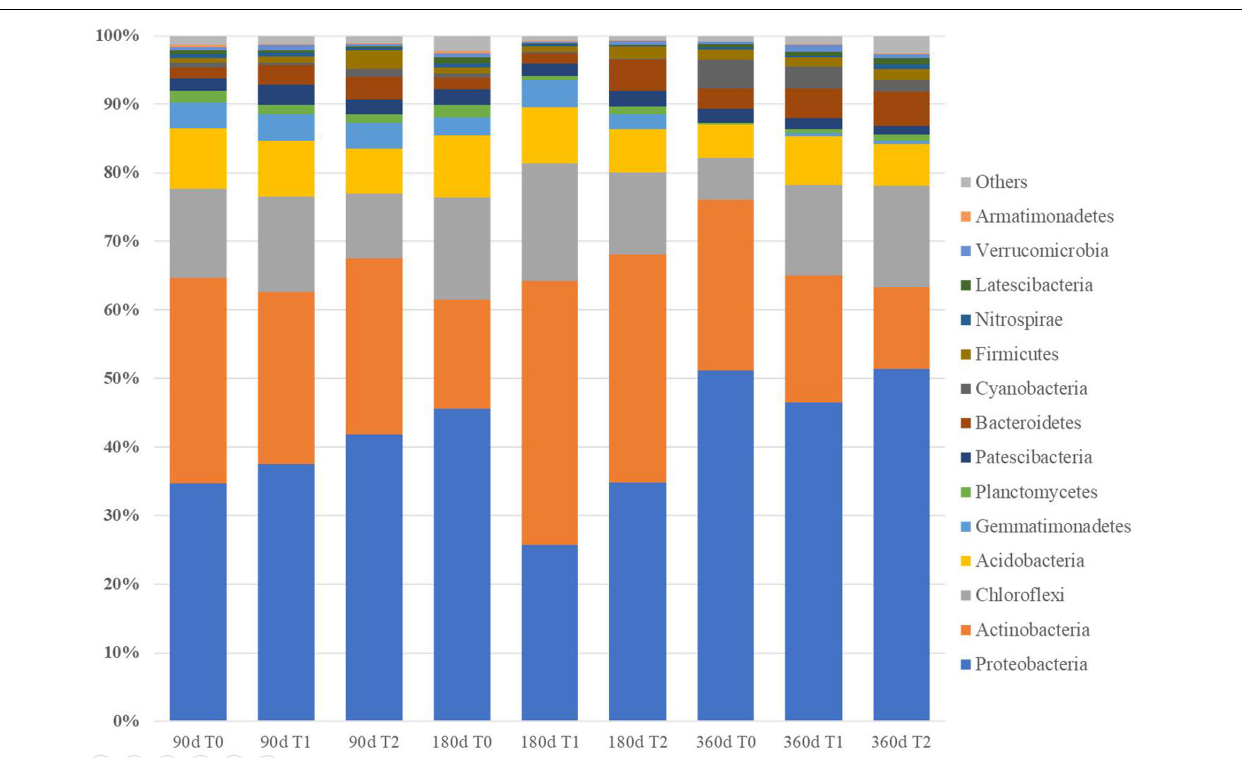
Frontiers in Microbiology |